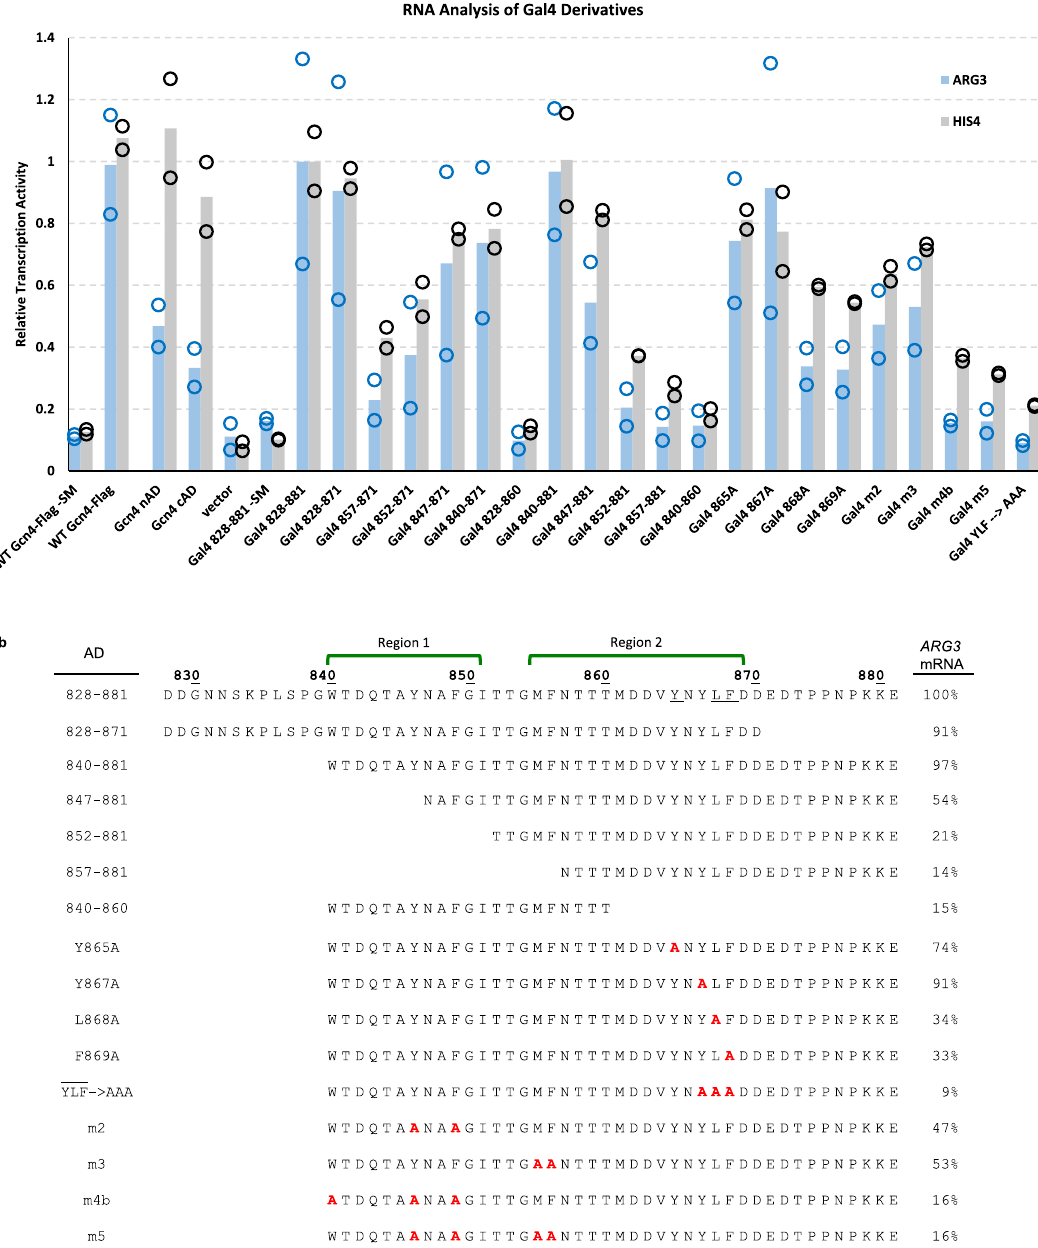
Fig. 2 Residues throughout Gal4 840 – 871 positively contribute to transcription activation. a RNA analysis of Gal4 AD-Gcn4 DBD derivatives. RNA levels measured by RT qPCR are normalized to ACT1 mRNA and Gal4 828 – 881 + SM is set to 1; data points are shown as open circles and the average value is shown as bars. b Sequence of Gal4-Gcn4 derivatives and summary of activation assays from a at ARG3 . Gal4 AD hydrophobic patches (green brackets above the sequence) and alanine mutations within these regions (red residues) are shown. See also Supplementary Fig.